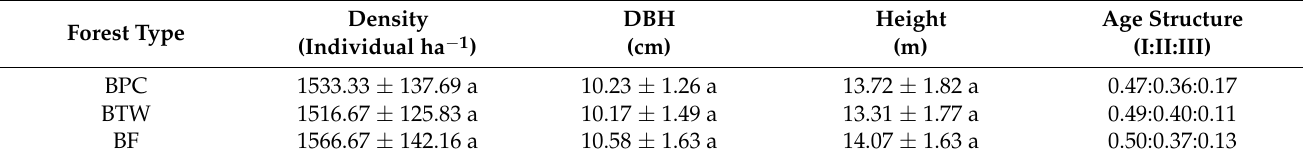
Table 2. Brief descriptions of the three experimental